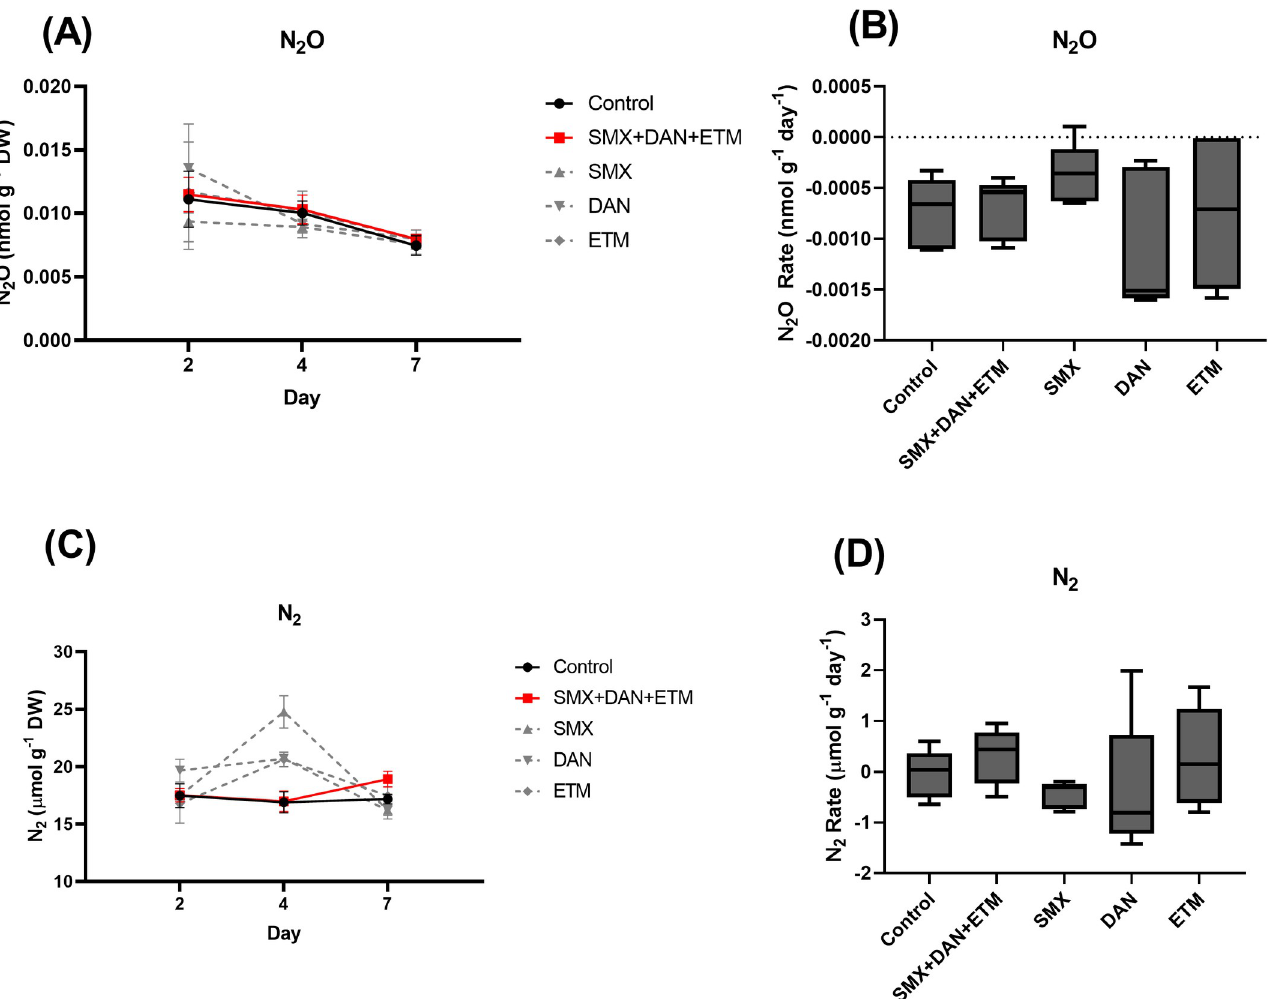
Fig 2. Mean ± SE dissolved (A) N 2 O, (C) N 2 concentrations in microcosms plotted across time (Day 2, 4, and 7) and whisker plots (min to maximum) of the rate of production for (B) N 2 O and (D) N 2 from microcosms exposed to control and experimental